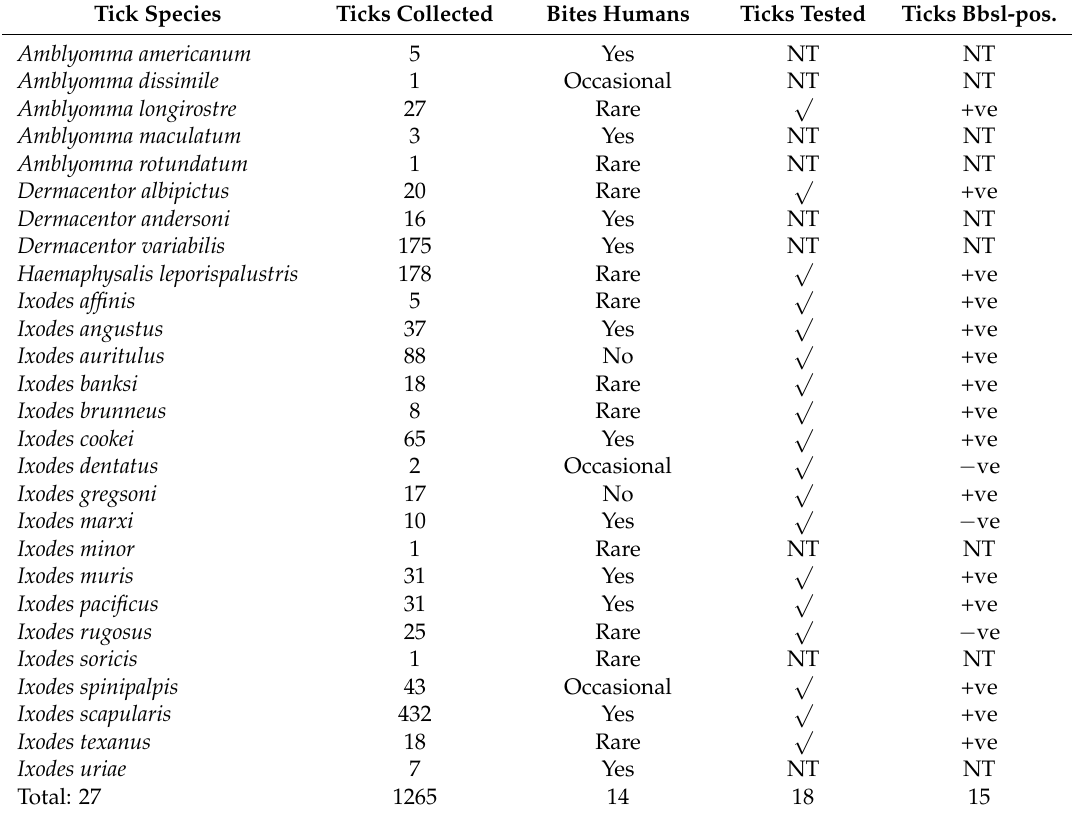
Table 1. Tick species collected from avian and mammalian hosts in Canada, 2013–2016. Tick Species Ticks Collected Bites Humans Ticks Tested Ticks